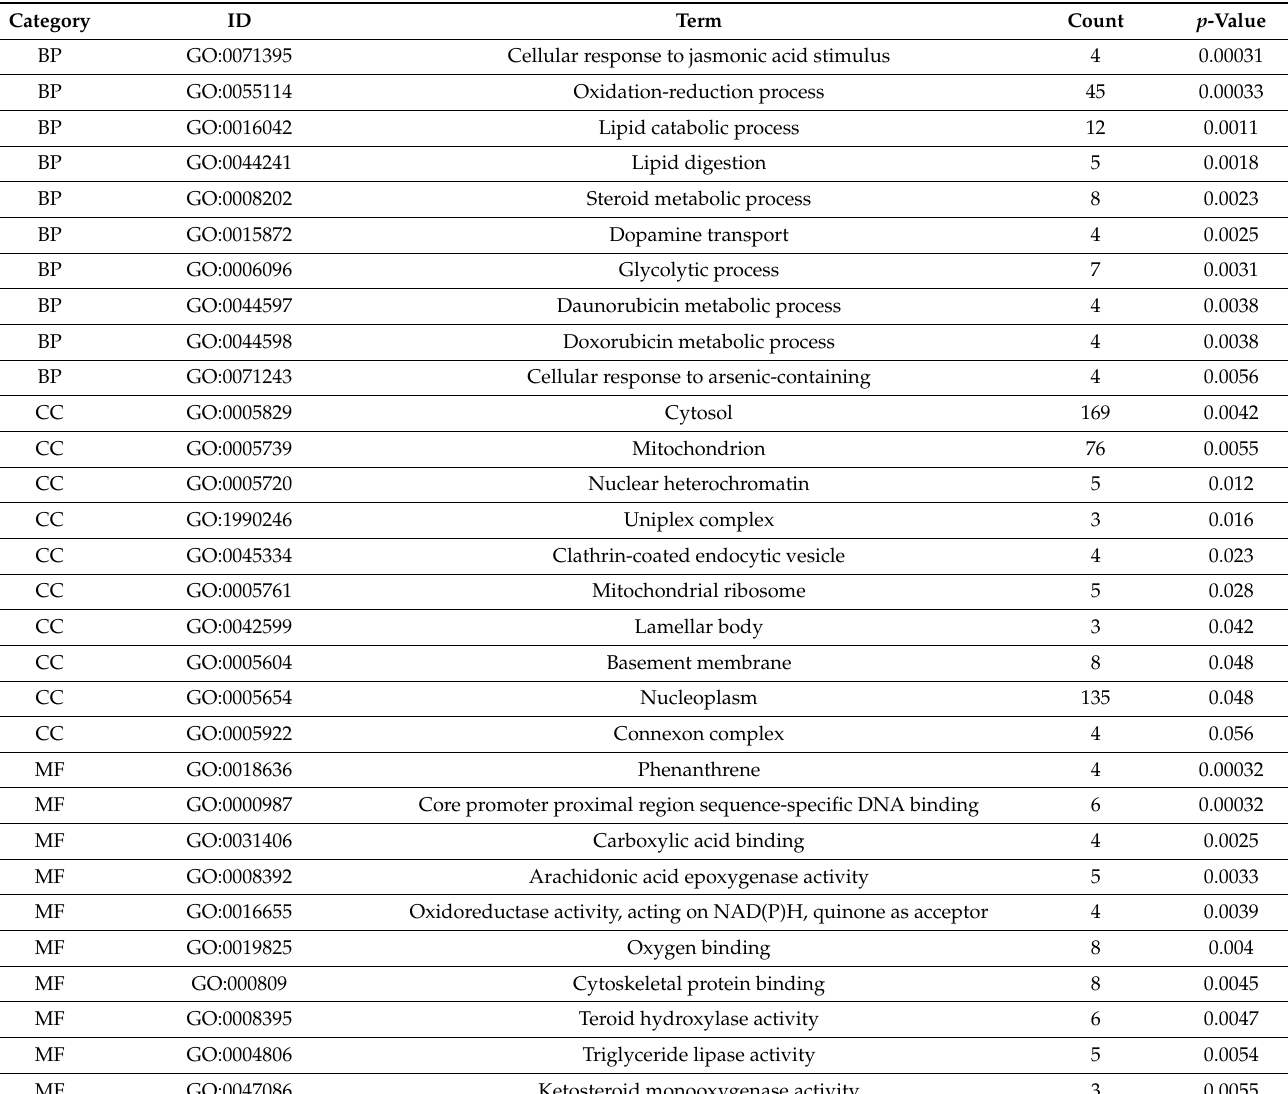
Table 6. Enrichment analysis of GO and KEGG pathway of genes involved in